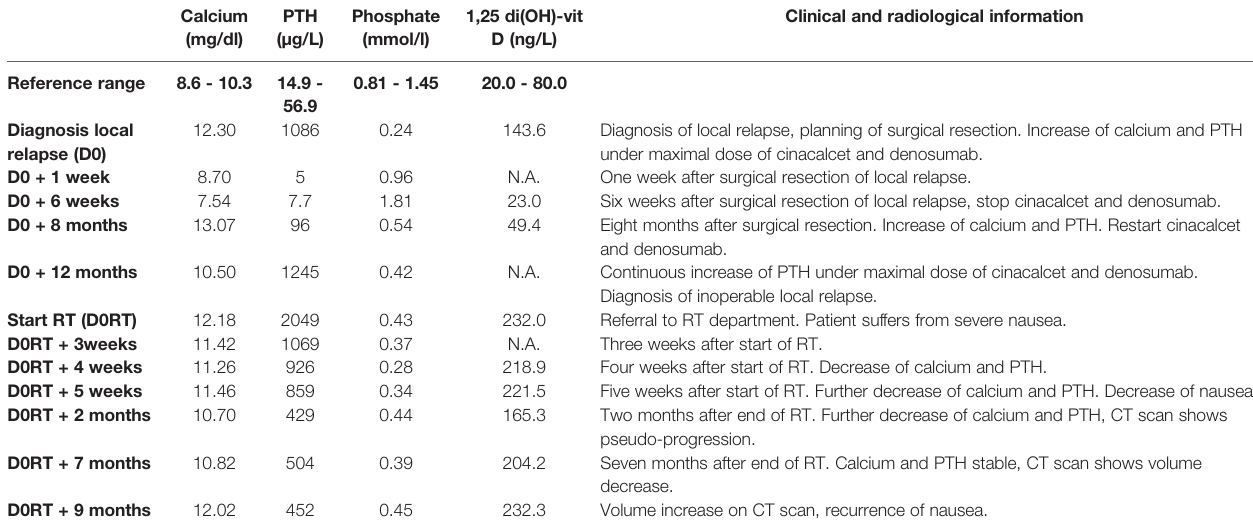
TABLE 1 | Timeline with evolution of biochemistry, clinical symptoms and radiological